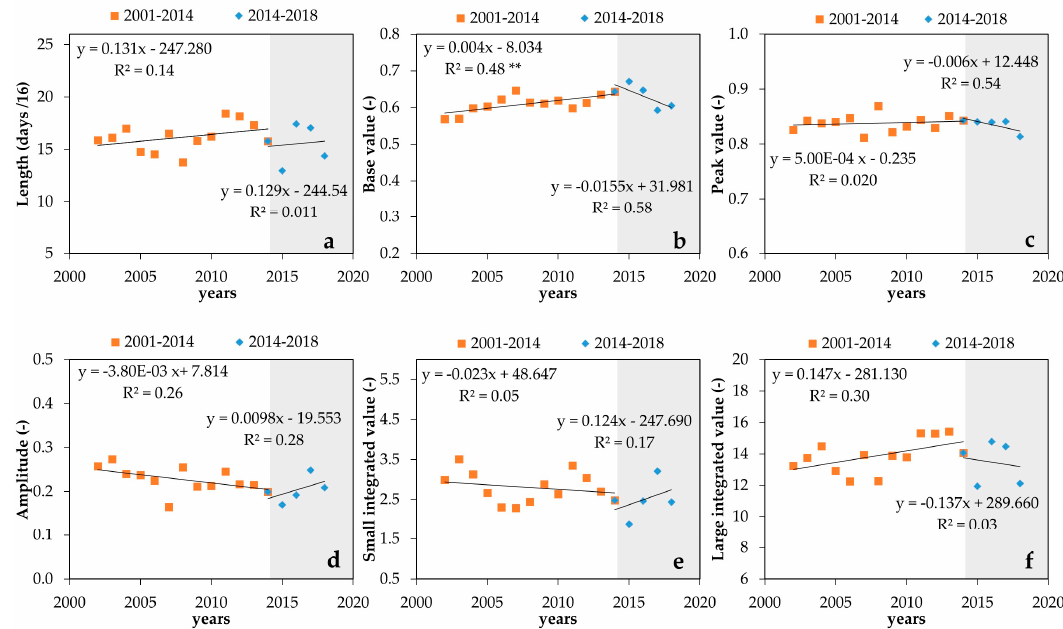
Figure 8. Seasonal parameters in CS1: ( a ) length value, ( b ) base value, ( c ) peak value, ( d ) amplitude value, ( e ) small seasonal integral and ( f ) large seasonal integral. Significant p -value ( p < 0.05, 0.01 and 0.001) are indicated with *, ** and ***, respectively.